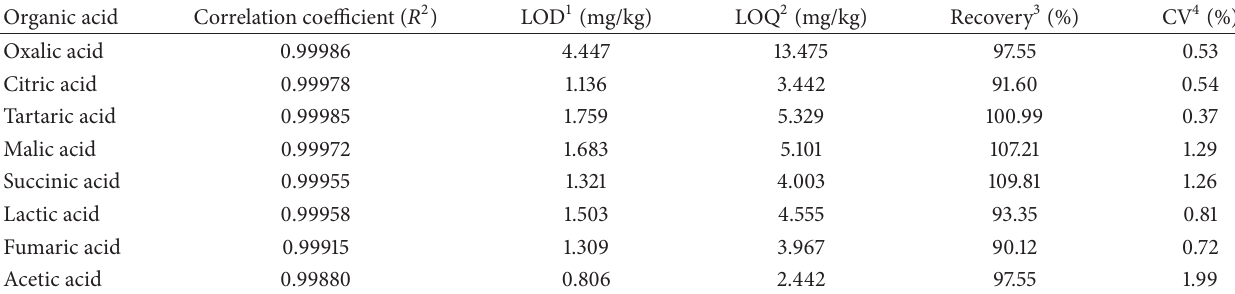
Table 2: Analytical parameters for HPLC analysis of organic